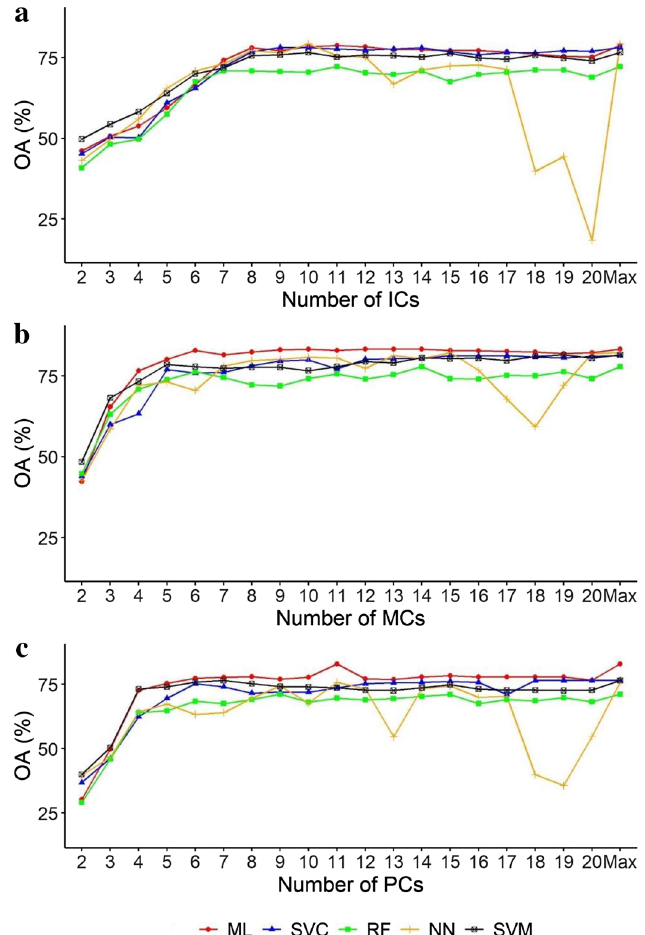
Figure 2. Overall accuracies (OA) and components of Minimum Noise Fraction ( a ), Independent Component Analysis ( b ) and Principal Component Analysis ( c ) by classification algorithms. MCs MNF components, ICs ICA components, PCs PCA principal components, Alg algorithms, ML Maximum Likelihood, SVM Support Vector Machine, SVC Linear type of SVM, RF Random Forest, NN Neural